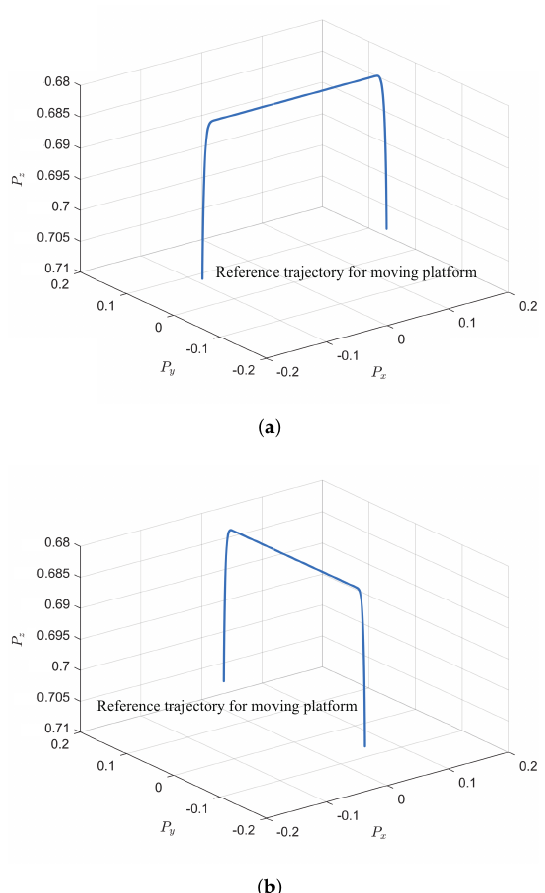
Figure 5. Reference trajectories of moving platform used for identification of the dynamic analytic model and model validation. ( a ) Reference trajectory for model parameter identification. ( b ) Reference trajectory for model